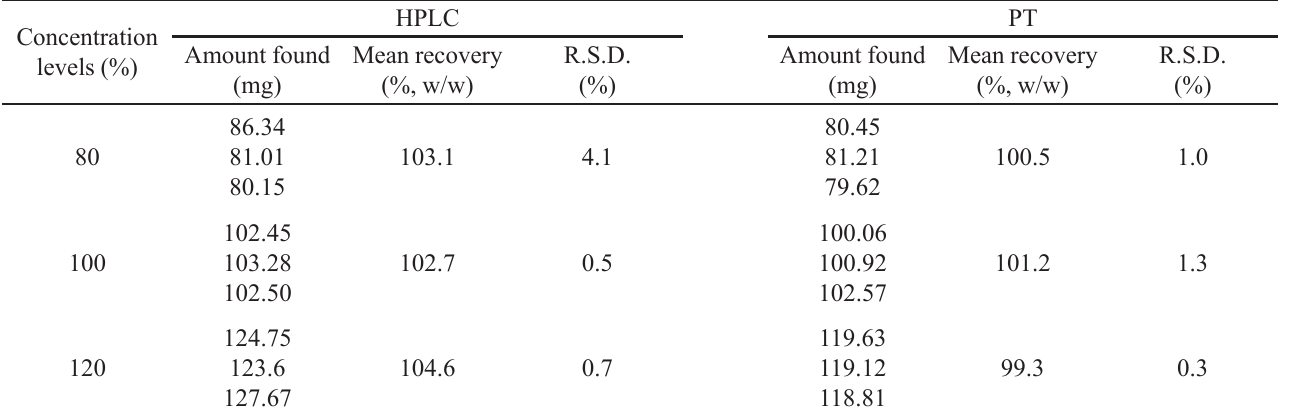
TABLE V - Results obtained for selectivity of PT method Sample Placebo